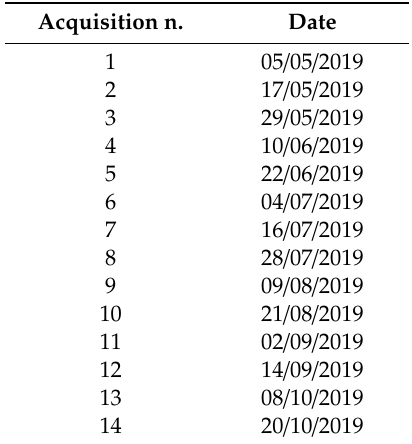
Table 6. Sentinel-1 descending SAR dataset. Date format is day / month / year. Acquisition n.